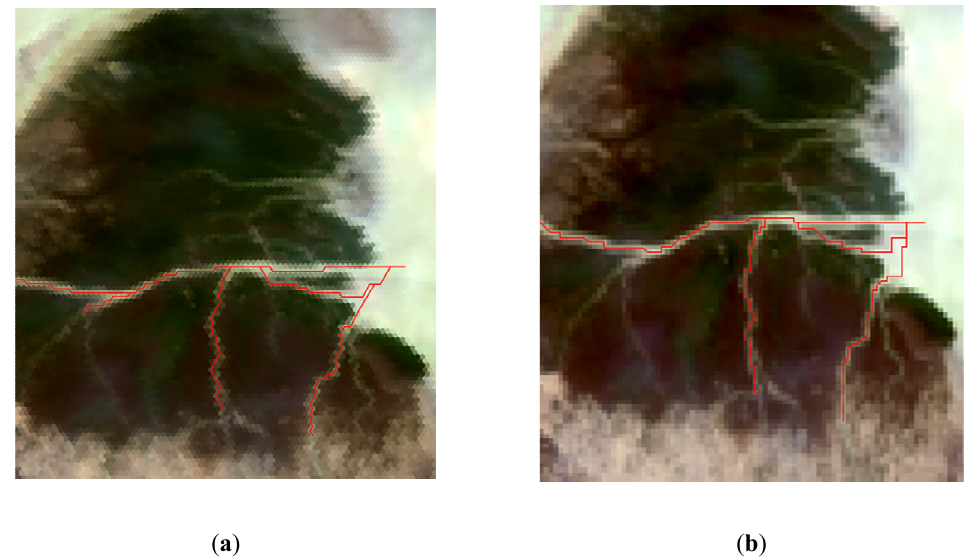
Figure 14. Original image and the hexagonal grid image for linear element extraction and the result of the refinement operation. ( a ) Landsat 8 hexagonal grid image of Level 18; ( b ) original remote sensing image of Landsat 8.